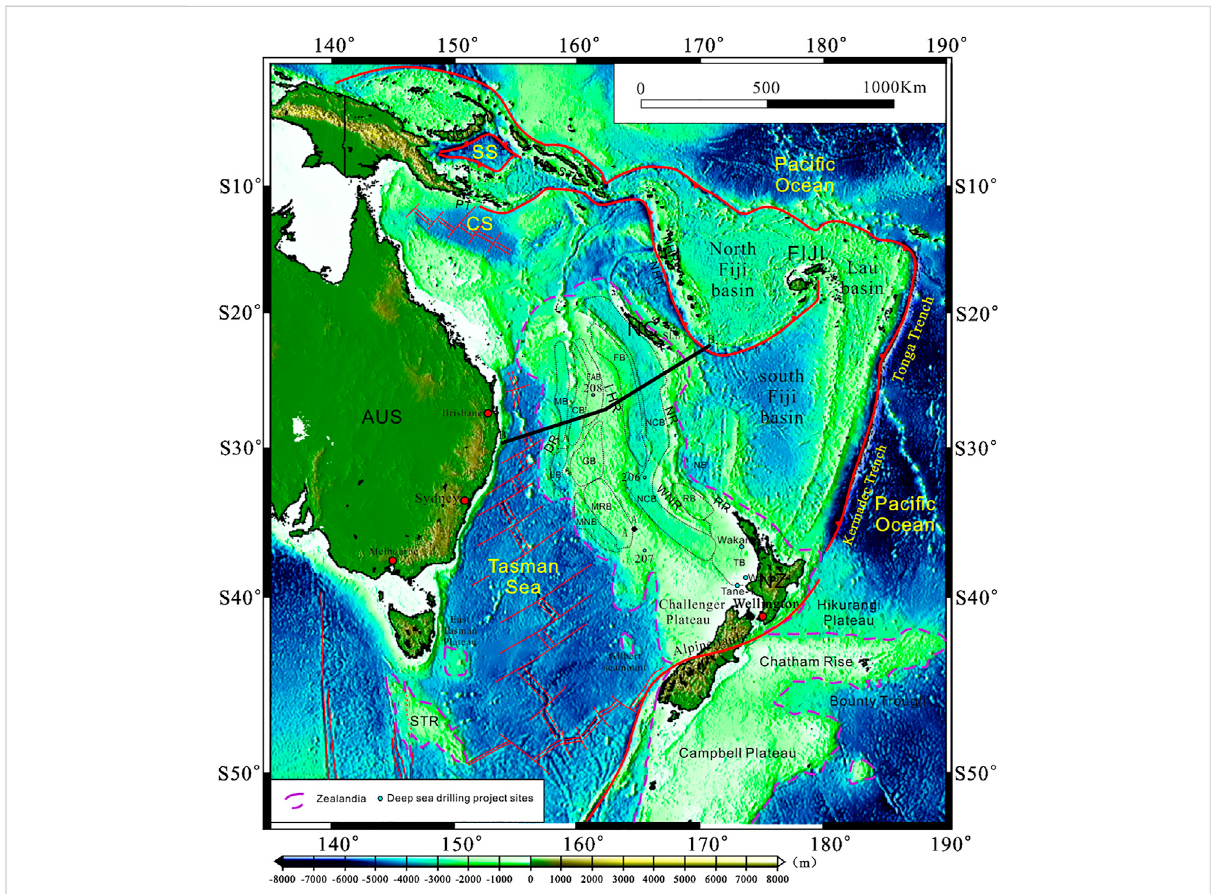
FIGURE 1 Tectonic location and division of tectonic units of the continent of